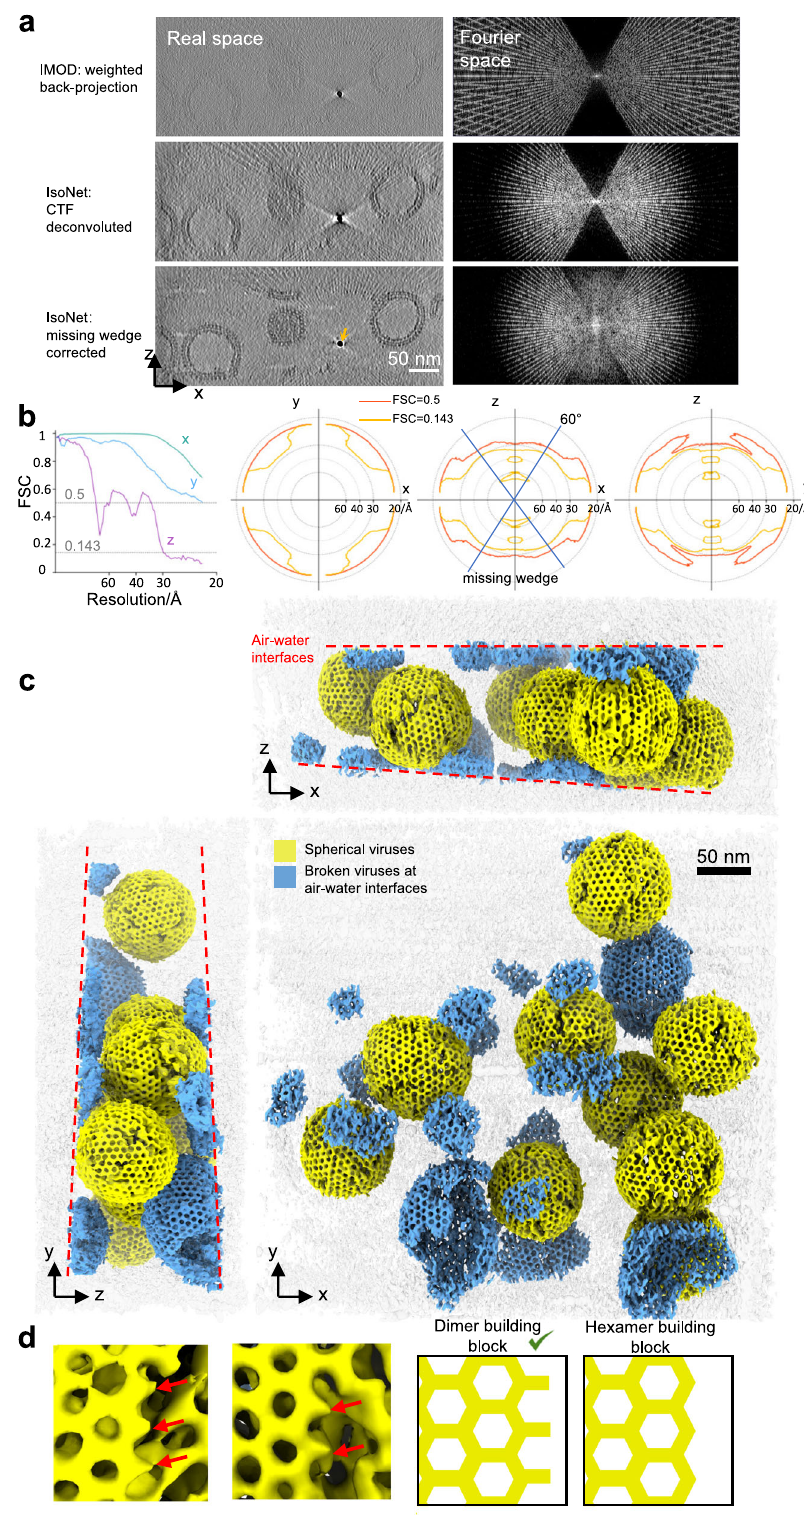
Fig. 3 | IsoNet reveals latticedefects in immatureHIV capsid.a XZ sliceviews of the tomogram reconstructed with WBP (top), CTF deconvoluted WBP tomogram (middle), and missing-wedge corrected tomogram (bottom), with their Fourier transforms on the right. The orange arrow indicates a gold bead. b 3D FSC of the two independent isotropicreconstructions, the left panel shows the FSC along the